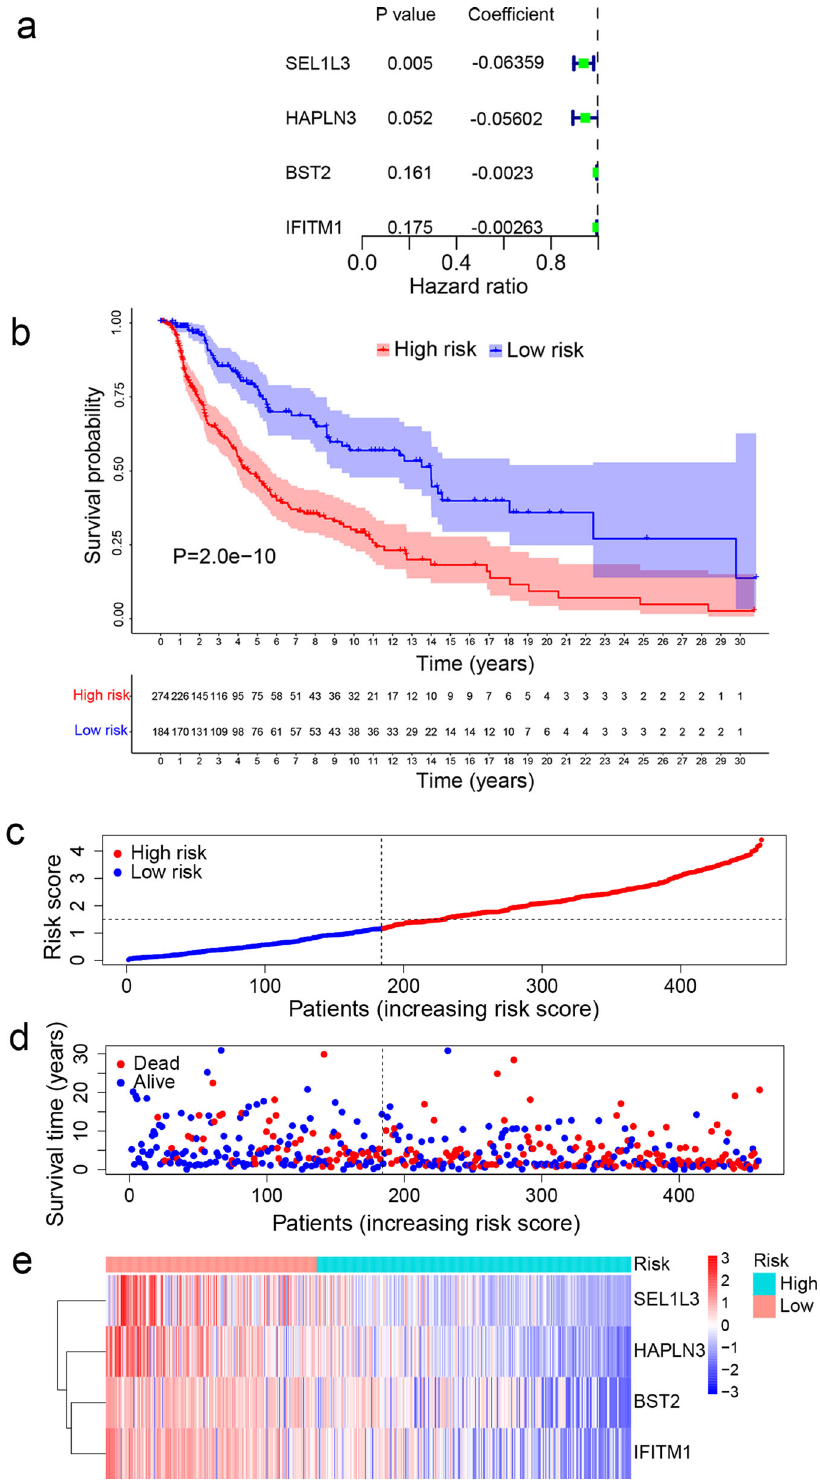
Fig. 2 Establishment of a tumor immune-related prognostic signature (TIR signature) for melanoma. a Cox proportional hazard regression model was used to construct a prognostic signature consisting of four genes ( SEL1L3 , HAPLN3 , BST2 , and IFITM1 ). The coef fi cient ( β ), P value, and hazard ratio of each gene were calculated by the model. b Kaplan – Meier curves of the overall survival of patients with high TIR risk scores and those with low TIR risk scores. Statistical signi fi cance was determined by the log-rank test. c All TCGA SKCM patients were ranked from the lowest to the highest TIR risk score. d The overall survival time and survival status of individual patients. The black dotted line represents the median TIR risk score that divides patients into low-risk and high-risk groups. e Heatmap of SEL1L3 , HAPLN3 , BST2 , and IFITM1 expression levels. Rows represent genes and columns represent patients.